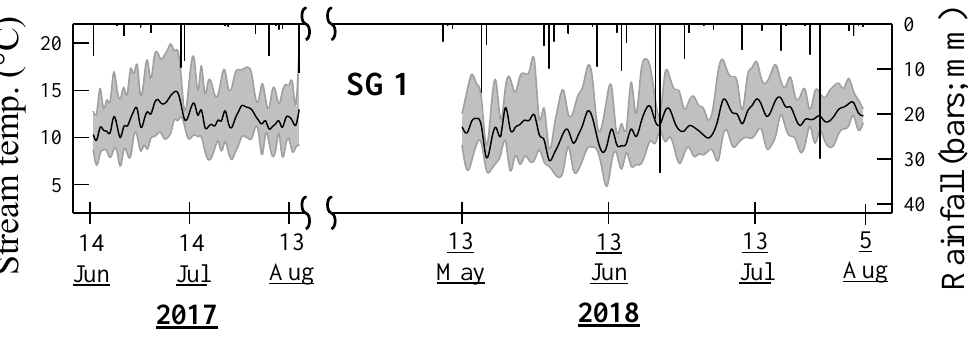
Figure 2. Daily stream thermograph at SG1 (black line is mean, grey area is range) and hyetograph for pre-BDA installation period (2017–2018).